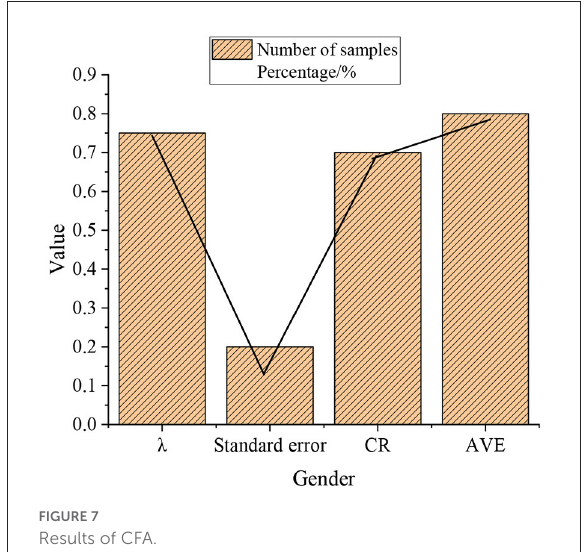
FIGURE7 Results of